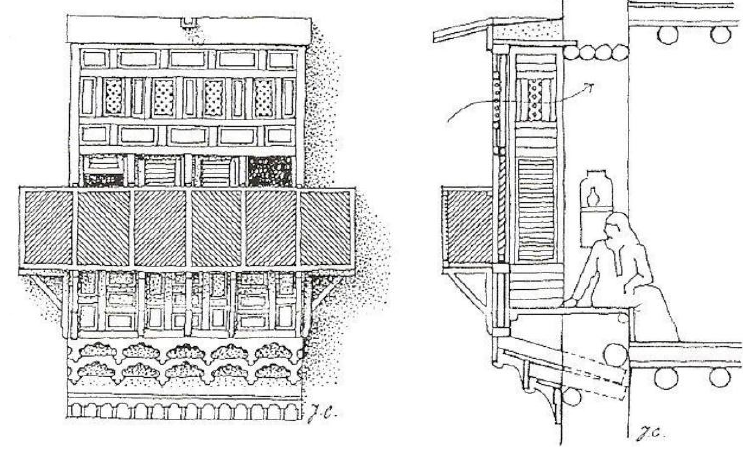
Figure 3. Details of Mashrabiya in elevation and section view (Ragette